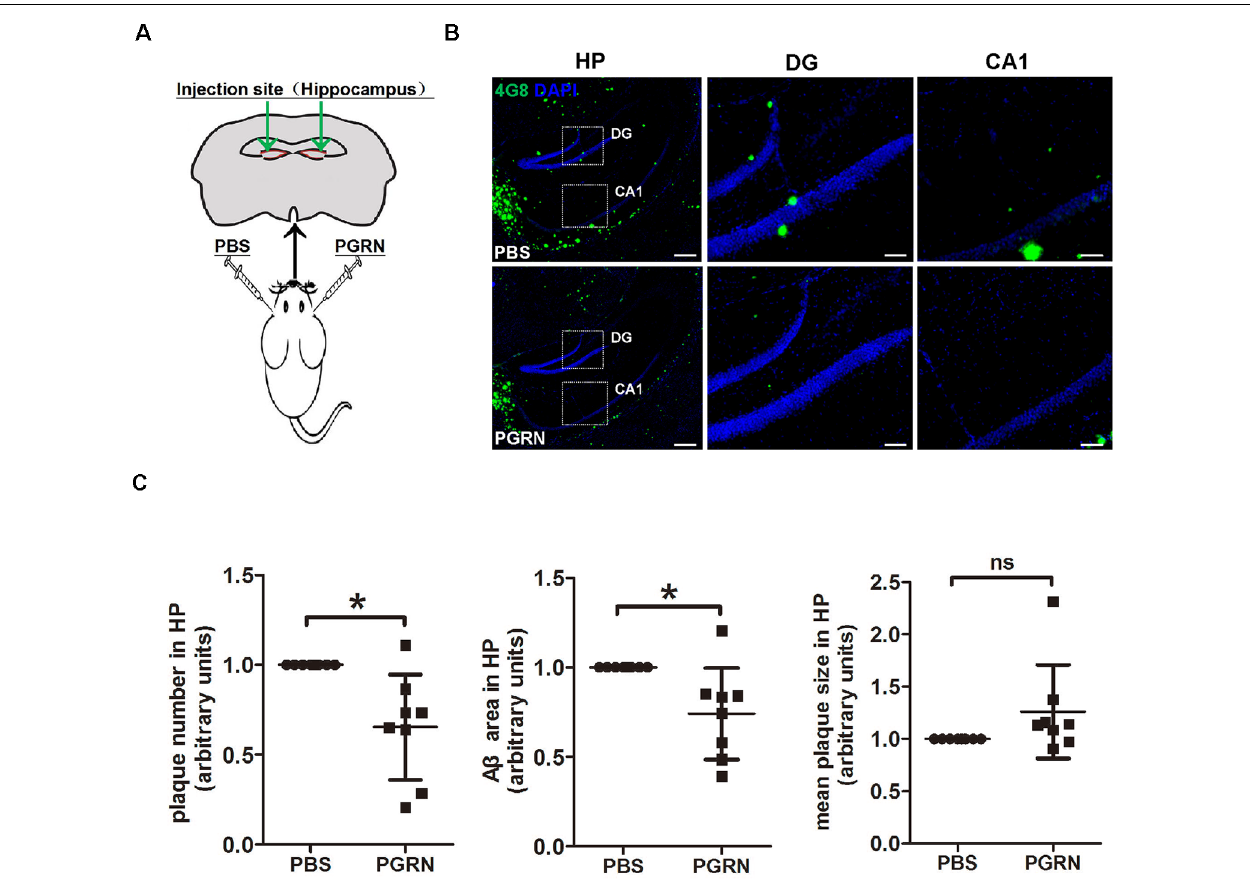
FIGURE 1 | Progranulin (PGRN) administration attenuates β -amyloid (A β ) deposition in the hippocampus of 5xFAD mice. (A) Schematic diagrams of PBS or PGRN injection into the mice hippocampus. The right hemisphere was injected with PGRN and the left hemisphere was injected with PBS as self-control. (B) Representative images of A β plaques of the hippocampus (HP) of 5xFAD mice injected with PBS (control) or PGRN. A β (4G8, green) and DAPI (blue). Scale bars, 200 µ m (HP), 50 µ m (DG, CA1). (C) Quantification of the area, number and mean size of A β plaques in the hippocampus, all values were normalized to left hemisphere levels for each mouse, n = 8, * p < 0.01, paired student’s t -test. ns, not significant.